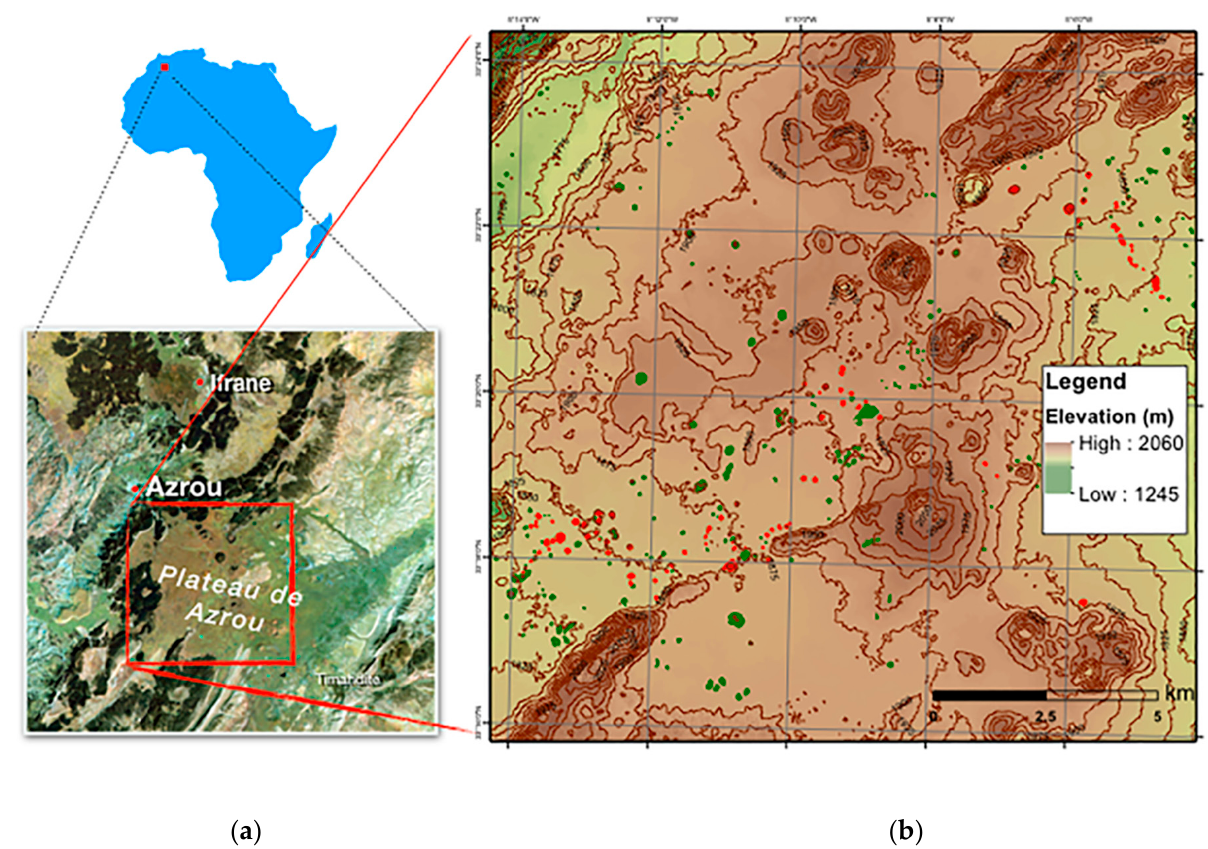
Figure 2. ( a ) Localization of the study area in Central Morocco. On the DEM on the right image ( b ), volcanic cones and calderas are clearly recognizable. The sinkholes analyzed in this research are shown in red, whereas the other sinkholes are shown in green.